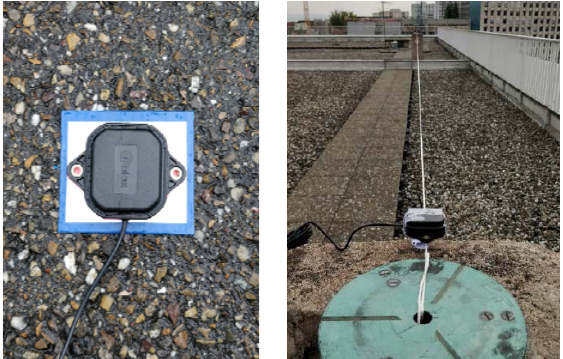
Figure 6 : Left, Ground measurement | Right, Dynamic measurement along a tight string